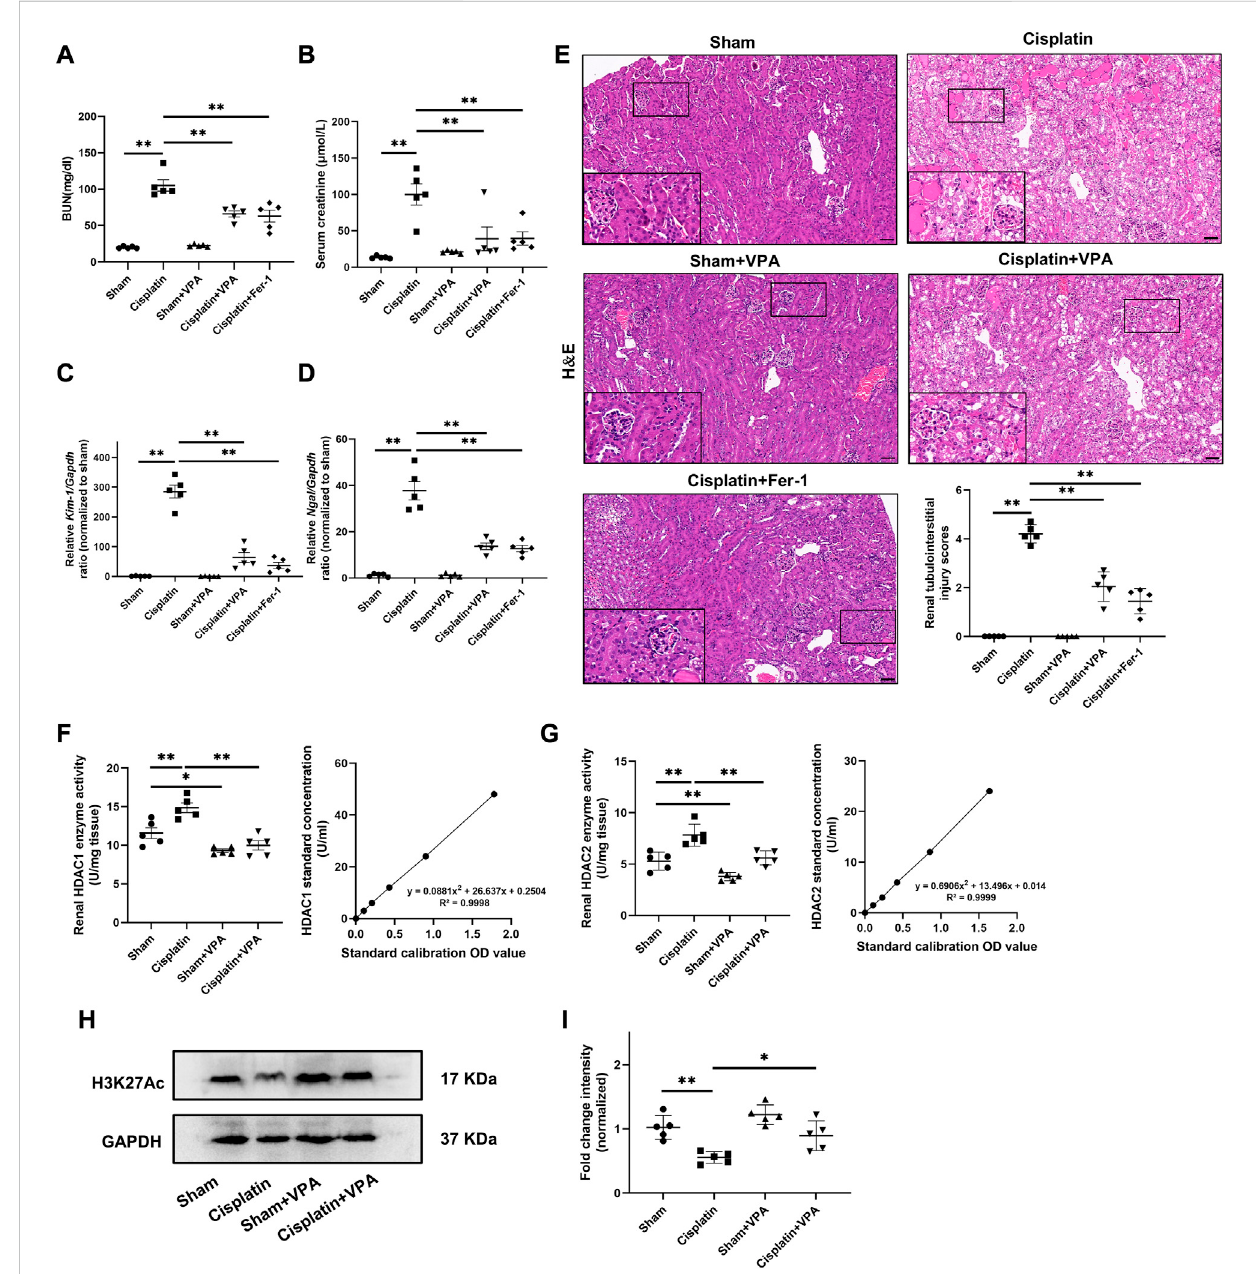
FIGURE 2 VPAtreatmentimprovesrenalinjuryandupregulatedthelevelofH3K27Acincisplatin-inducedAKImice.BUN (A) andSerumcreatinine (B) inkidneys of sham, cisplatin, sham + VPA, cisplatin + VPA and cisplatin + Fer-1 group. Quanti fi cation of real-time PCR from different groups of mice as indicated, including Kim-1 (C) and Ngal (D) ,respectively.RepresentativeimagesofH&Estainingandquantitativeanalysis (E) ofrenaltubulointerstitialinjuryscoresin different groups as indicated. Enzyme activities and standard curve line of HDAC1 (F) and HDAC2 (G) in the renal tissue of mice. Representative images of Western blot (H) and quantitative analysis (I) of the level of H3K27Ac of kidneys in different groups as indicated. n = 5. Scale bar = 50 μ m ✱✱ value p < 0.01, ✱ value p < 0.05. Statistically analyzed via a one-way